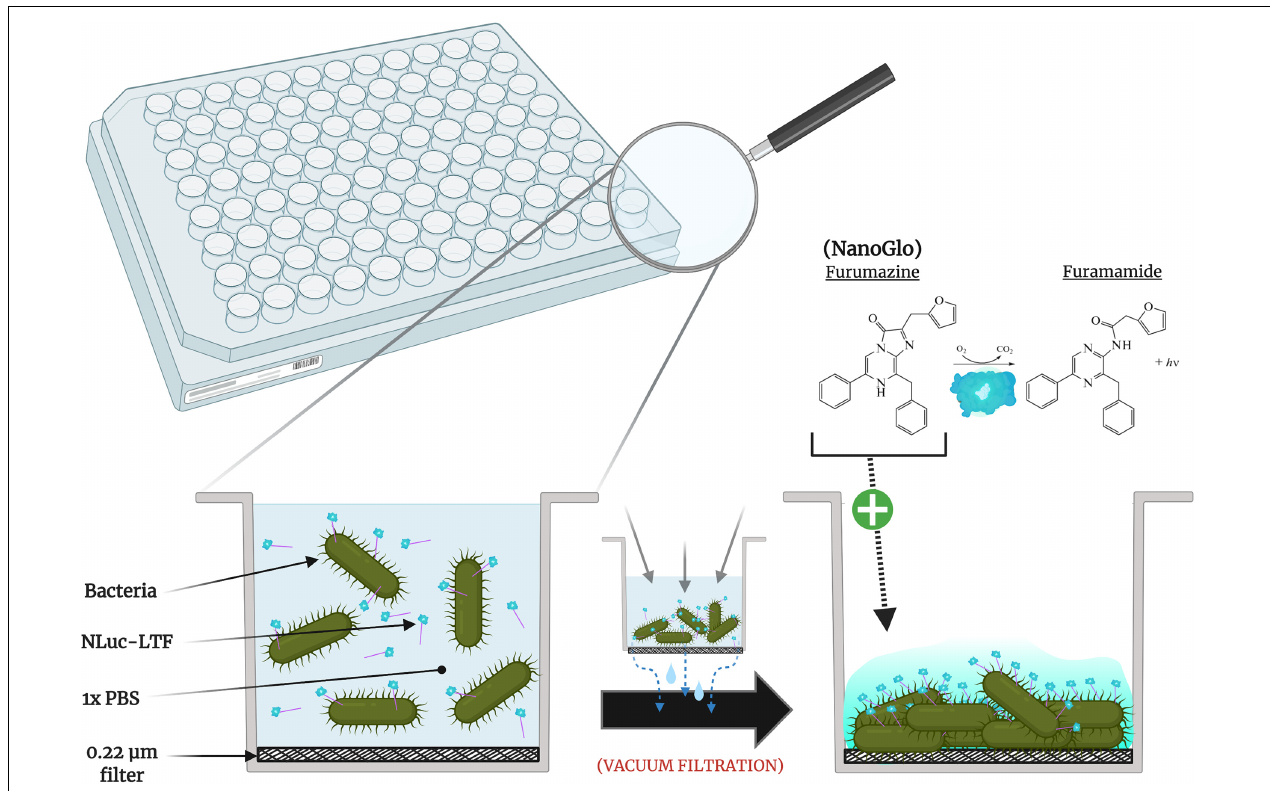
FIGURE 1 | Cross-sectional view of NLuc-LTF sample well in a 96-well plate. With gp37-facilitated adsorption occurring C-terminally, N-terminal NanoLuc is free to interact with added NanoGlo substrate to produce